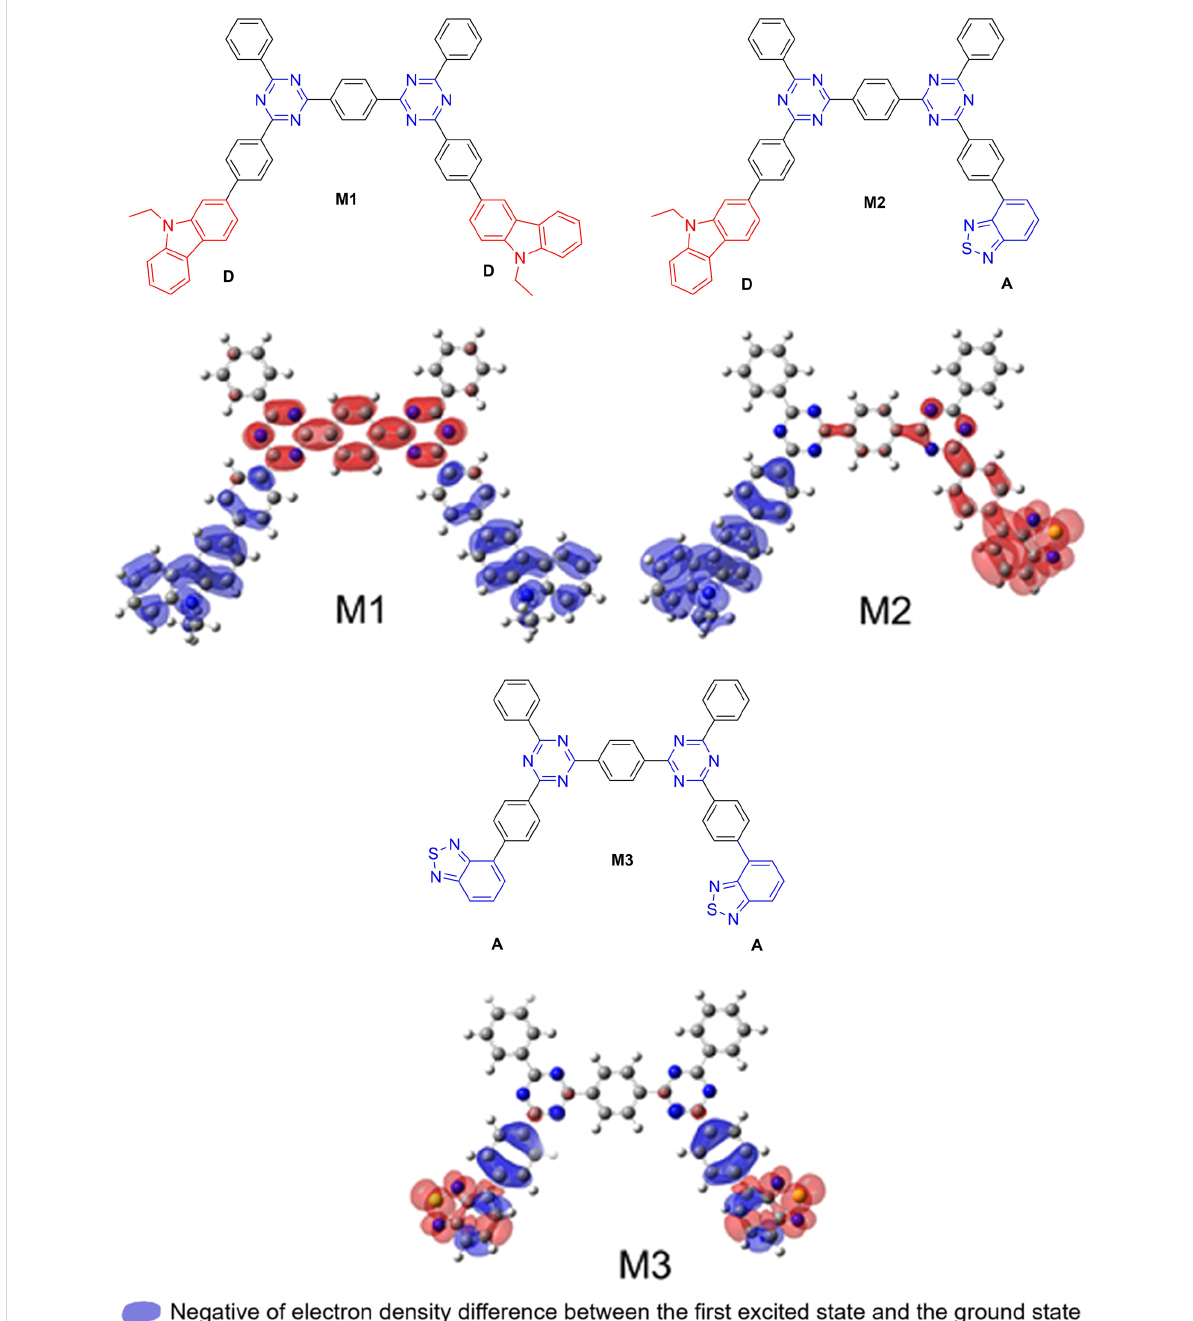
Figure 3: Proposed model fragments and electron density differences of M1 – M3 in P8 . Adapted with permission from [49]. Copyright (2019) Amer- ican Chemical Society. This content is not subject to CC BY 4.0.